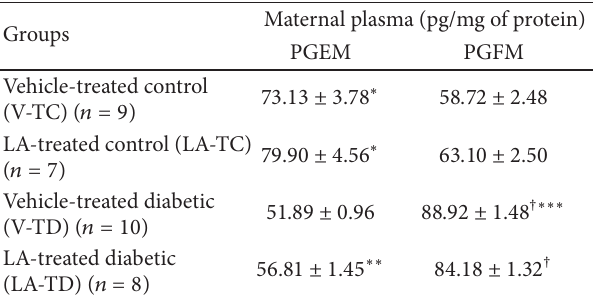
Table 11: PGEM and PGFM in maternal